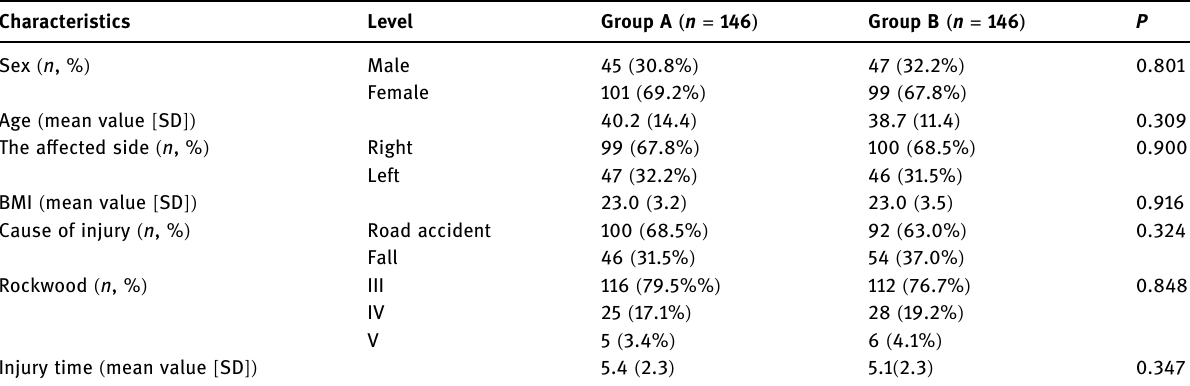
Table 2: Matched patient ’ s preoperative characteristics Characteristics